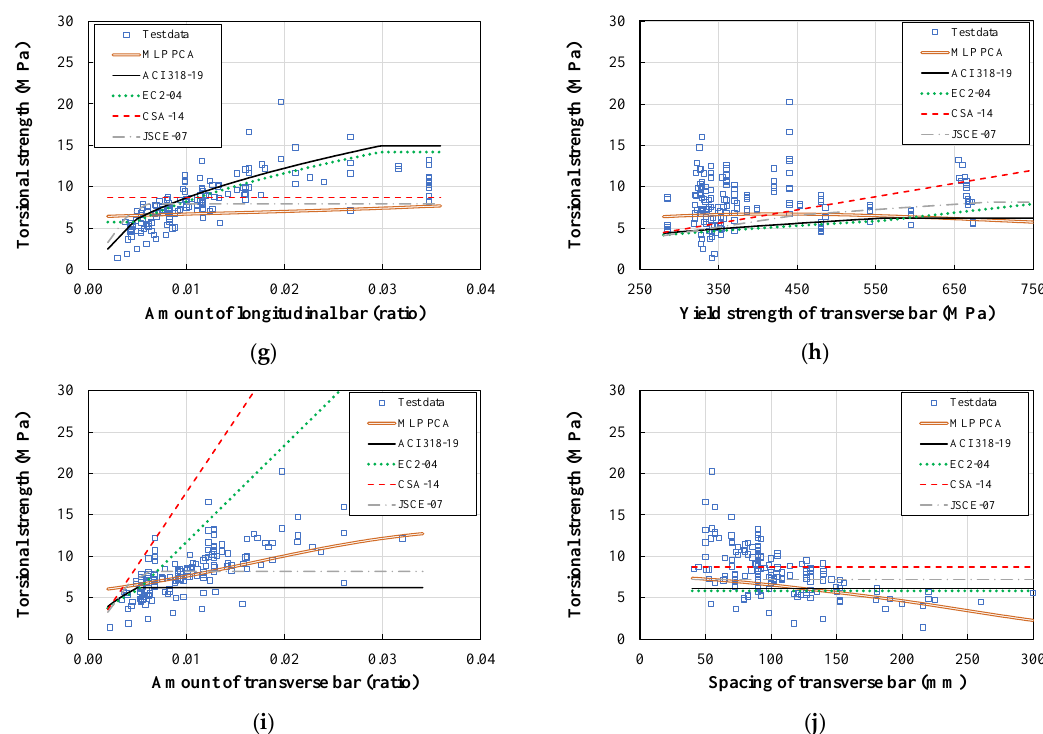
Figure 5. Parametric study using PCA: ( a ) beam width; ( b ) beam height; ( c ) closed beam width; ( d ) closed beam height; ( e ) concrete strength; ( f ) yield strength of longitudinal bar; ( g ) amount of longitudinal bar; ( h ) yield strength of transverse bar; ( i ) amount of transverse bar; ( j ) spacing of transverse bar.